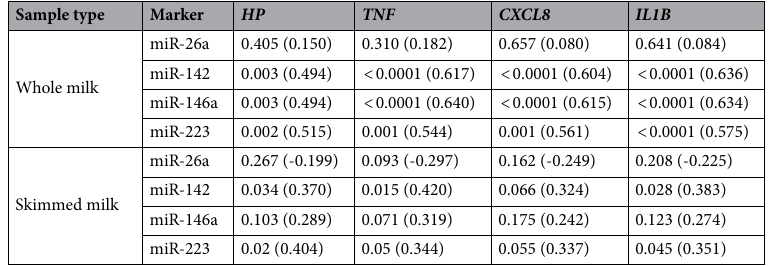
Table 1. Spearman correlations between the expression levels of miRNAs in whole and skim milk and the levels of inflammatory markers in matched milk cell samples. Data are presented as P -value (Rho